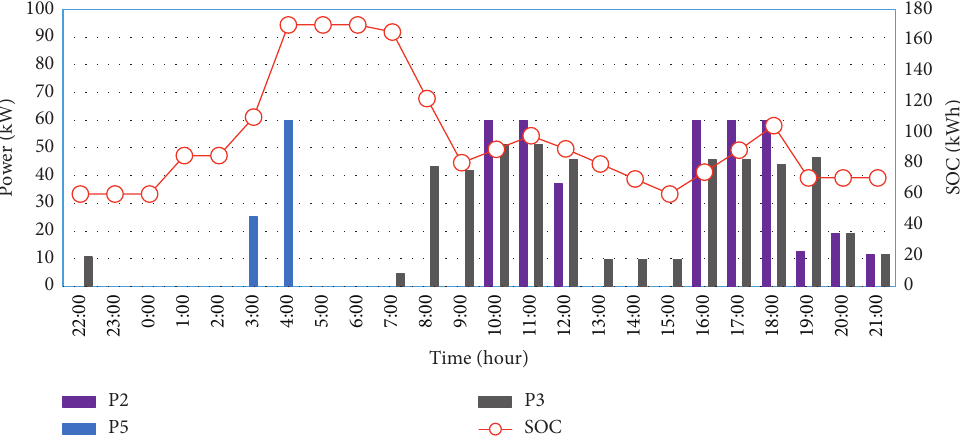
Figure 11: Batteries operation in case